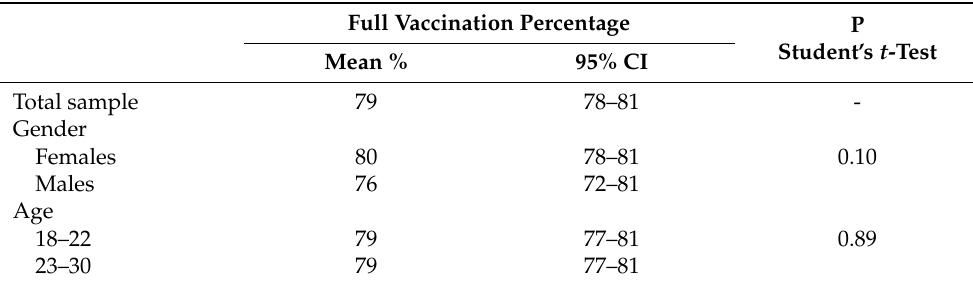
Table 2. Full vaccination percentage in total sample and comparison according to demographics.